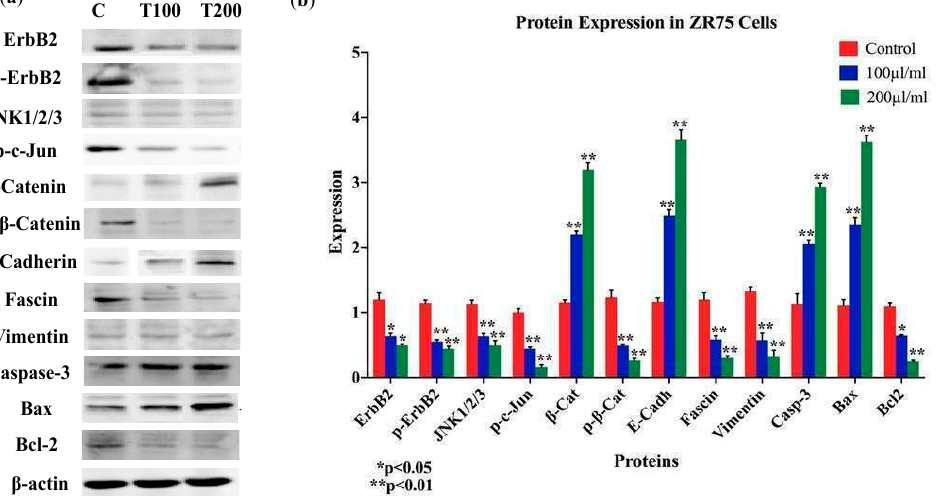
Figure 8. ( a , b ) Protein expression and molecular mechanisms of EA inhibitory actions in ZR75 cell line. This plant extract induces an overexpression of E-cadherin, β -catenin, and downregulation of vimentin and fascin; in addition, pro-apoptotic markers Bax and Caspase-3 are upregulated in comparison with their control, while anti-apoptotic marker Bcl-2 is inhibited. Furthermore, EA plant extract inhibits the phosphorylation of ErbB2 and β -catenin, as well as JNK1/2/3 expression. β -actin served as a control in this assay. Cells were treated with 100 and 200 µL/mL of EA extract for 48 h, as explained in the materials and Methods section. ( a ) Blot image and ( b ) quantification of bands.